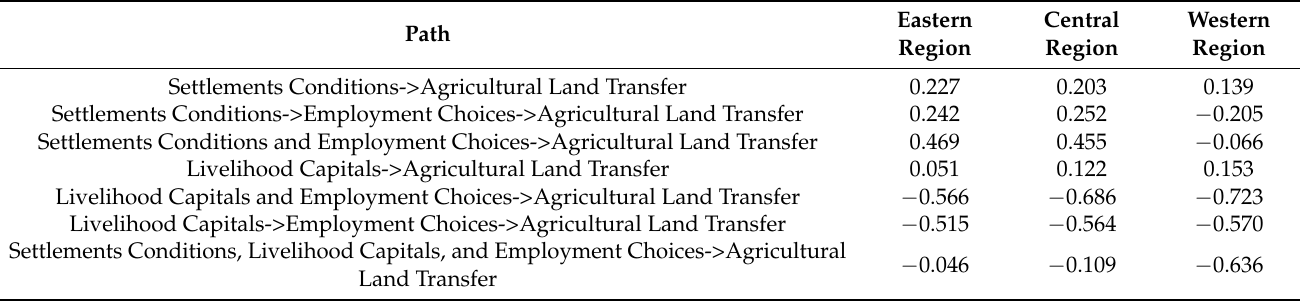
Table 8. The direct, indirect, and total effects of livelihood capitals and rural human settlements on agricultural land transfer in different